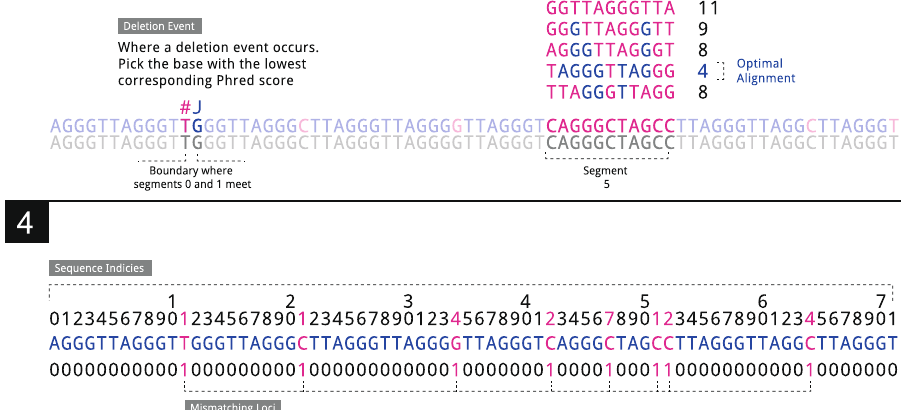
Figure 7. The algorithm that determines the indices of divergence from the telomere sequence. 0 : We observe a sequencing read 1 : We split the read into ‘segments’ (11 in total in our example) such that each segment is a substring of the original sequence and that every other segment consists of unbroken telomere sequence. In our example we see that segments 1,3,5,7,9,11 contain unbroken telomere sequence. 2 : Each segment containing a telomere hexamer is ‘expanded‘ to capture the full extent of the surrounding telomere sequence. The number of segments is reduced by 2. 3 : When two segments both containing the telomere hexamer are adjacent after Step 2 this indicates a deletion event. We take the loci with the lowest corresponding Phred score. For any segment that does not contain a telomere hexamer and where the length of the segment is greater or equal to 4 apply we conduct a basic alignment of all possible telomere offset telomere sequences. The telomere sequence with the lowest Hamming distance is taken as a local alignment for that segment. Where two alignments are equal the one with the lowest average Phred score is preferred. 4 : Sequence loci that are not in a complete hexamer or were mismatched in the Hamming alignment step are taken as mismatching loci. m for this example is given in the final line of the